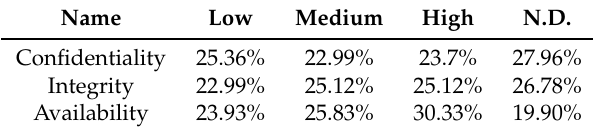
Table 3. Distribution of CIA requirements for configuration I.